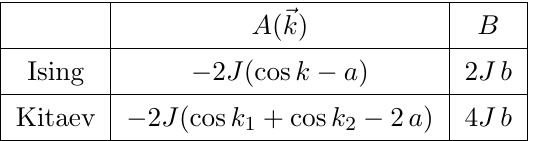
Table 2 . Parameters for lattice